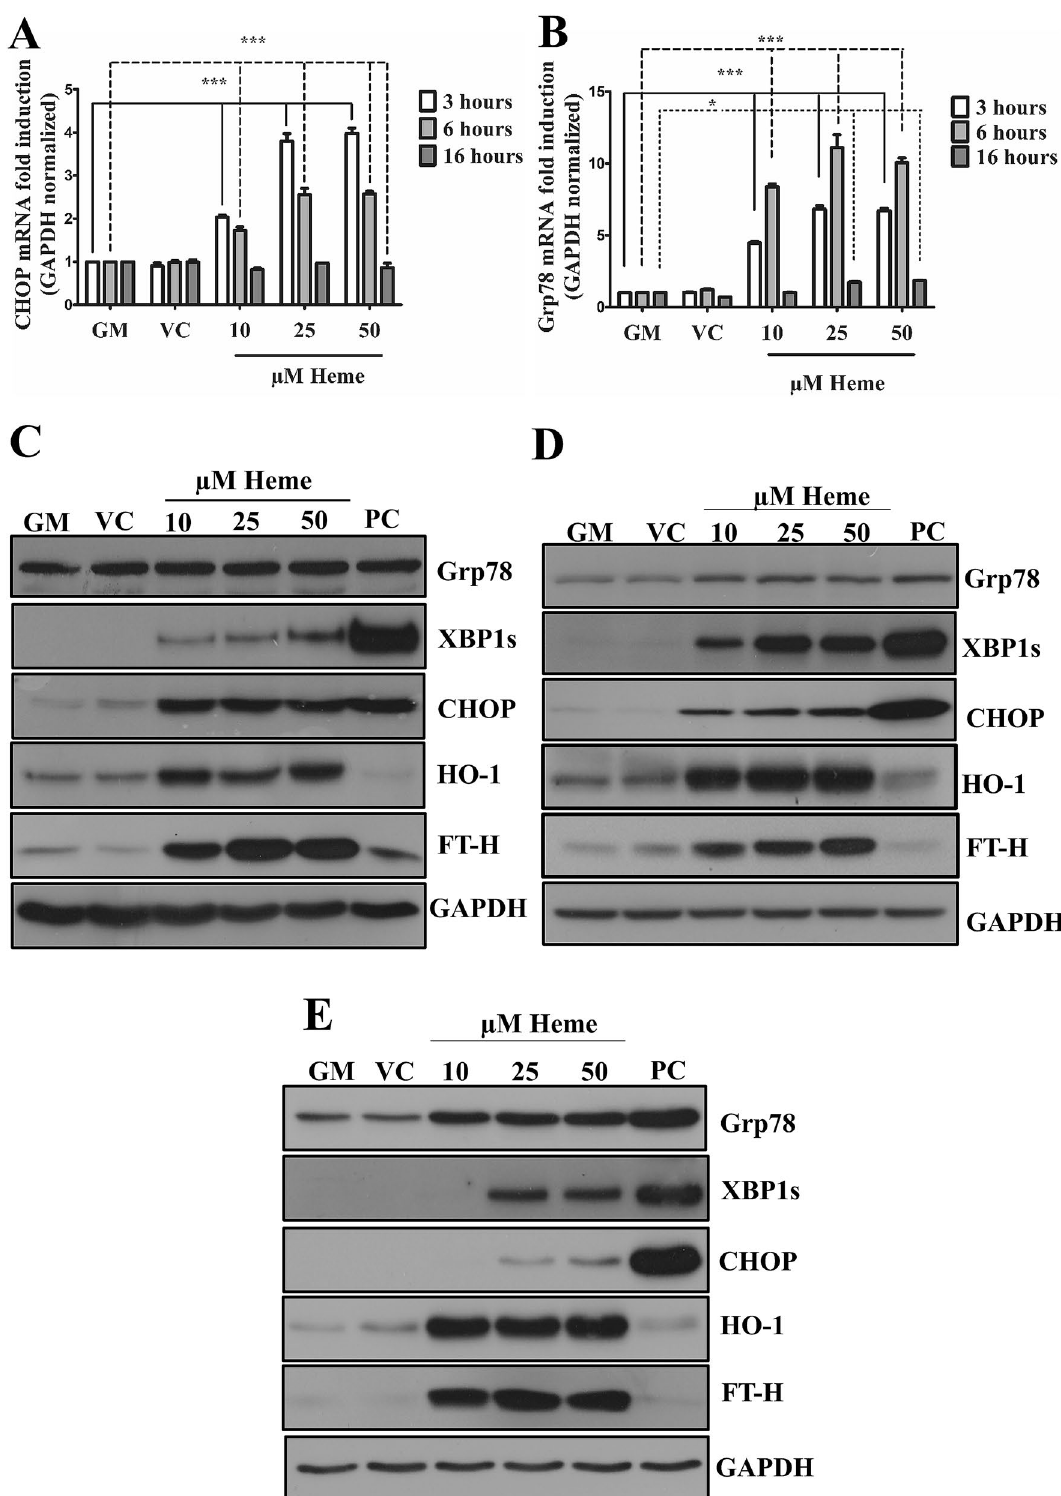
Figure 2. Heme activates ER stress in EC cultures in a time- and dose-dependent manner. ECs were treated with various doses of heme (10, 25, and 50 μM) or corresponding vehicle solution to the highest heme dose (50 μM) in serum- and antibiotics-free CM199 for 2 h, then the medium was changed to CM199 with 10% FCS and antibiotics. Thapsigargin (1 μM) treated cells were used as positive control. ( A ) Relative expression of CHOP and ( B ) Grp78 mRNA were analyzed after 3, 6, or 16 h and normalized to GAPDH. Representative immunoblots of three independent experiments are shown representing Grp78, spliced XBP1, CHOP, HO-1, and ferritin heavy chain levels ( C ) 3, ( D ) 6, and ( E ) 16 h after the heme treatments. GM growth medium, VC vehicle control, PC positive control. Data are shown as mean ± SEM of three independent experiments. Immunoblots are cropped from different parts of the same gel. Uncropped immunoblots are presented in the Supplementary information. Statistical analysis was performed by one-way ANOVA test followed by Bonferroni correction. A value of p < 0.05 was considered significant. * p < 0.05, *** p <